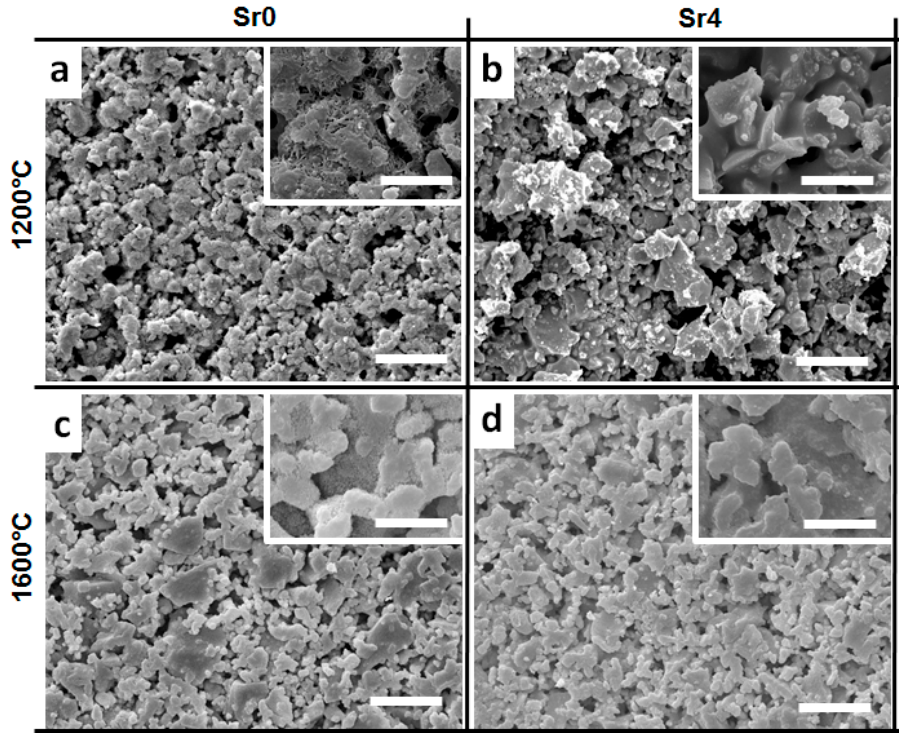
Figure 3. Microstructures of different cement formulations with dwell time of high-temperature powder synthesis equal to 15 min: ( a ) Sr0, 1200 °C; ( b ) Sr4, 1200 °C; ( c ) Sr0, 1600 °C; ( d ) Sr4, 1600 °C after 24 h at 37 °C. Scale bar: Image = 20 µm, insets = 5 µm.